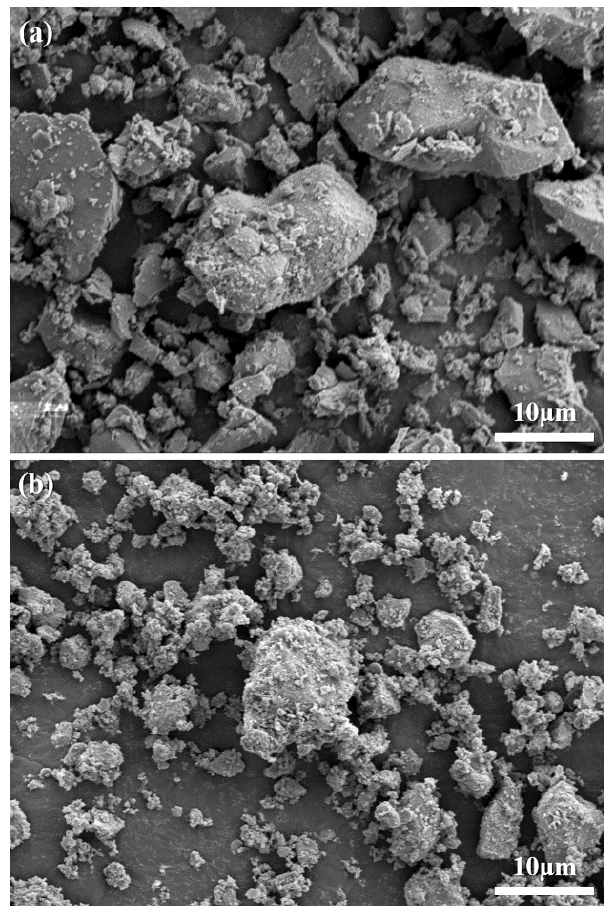
Figure 2. Scanning electron microscopic images of the CS powder before hydration ( a ) and after hydration in distilled water ( b ).